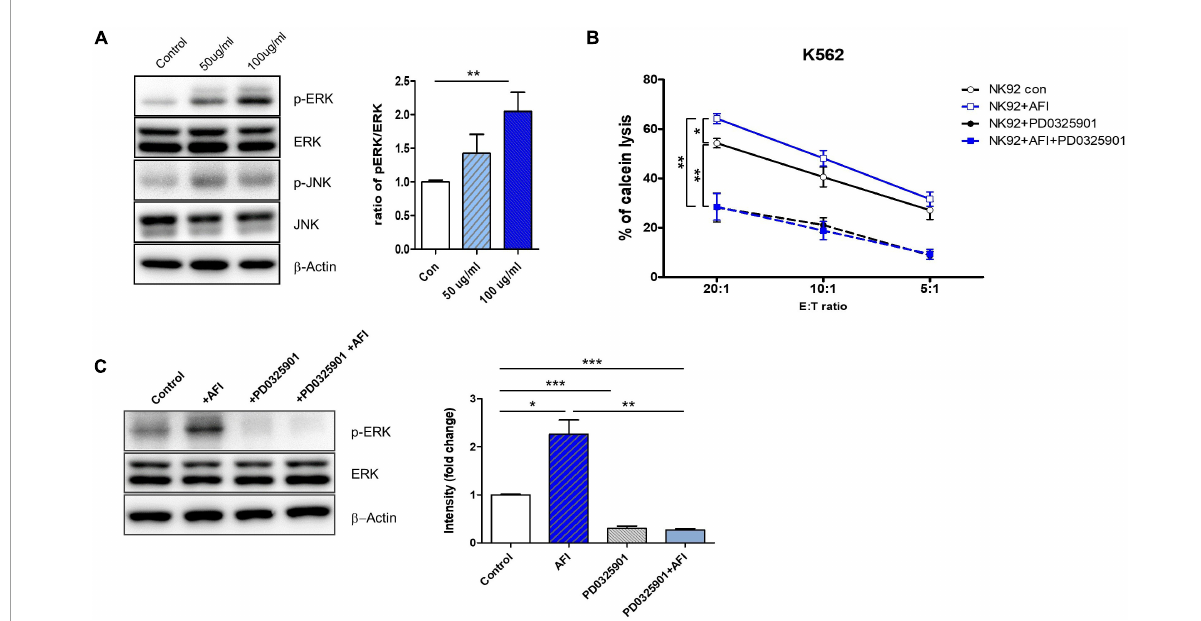
FIGURE2 Aurantii Fructus Immaturus (AFI) enhances NK cell activity through ERK pathway. (A) Extracellular signal-regulated protein kinase (ERK) and c-Jun N-terminal kinases (JNK) analyzed by Western blotting after the treatment of AFI in NK cells. β -actin served as a loading control. Right graph represents relative intensity defined as the intensity of the ERK and p-ERK normalized to β -actin. NK cells were cultured for 24 h either alone, in the presence of AFI, in the presence of an inhibitor of ERK (PD0325901), or in the presence of AFI with the inhibitor of ERK. Thereafter (B) cytotoxicity and (C) ERK signal were investigated. Phosphorylation of ERK signals was examined by western blotting in NK cells under the indicated conditions. Right graph represents fold change values of intensity compared to control. Bars represent the mean ± SEM of three independent experiments * p < 0.05, ** p < 0.01 and *** p <